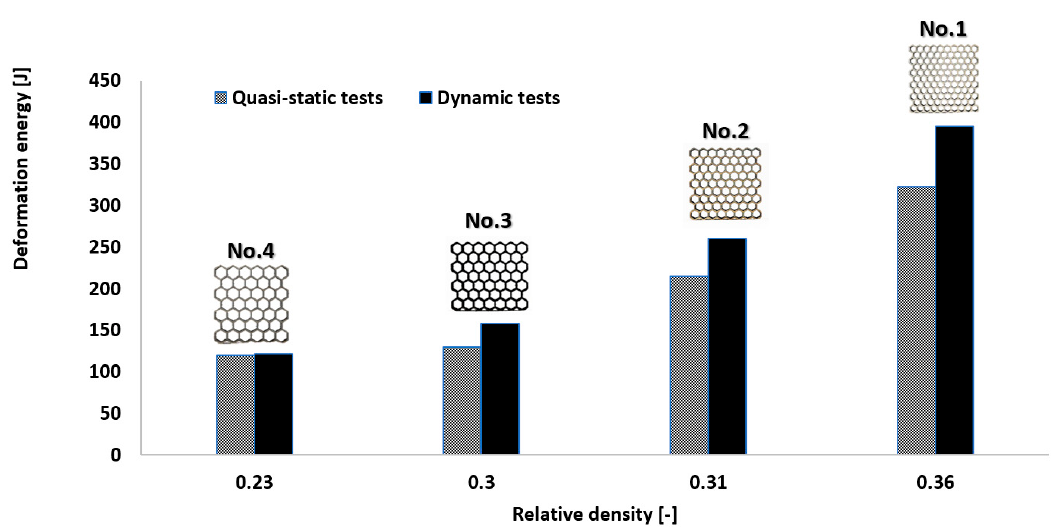
Figure 22. The influence of relative density on structural deformation process under static and dynamic loading conditions.